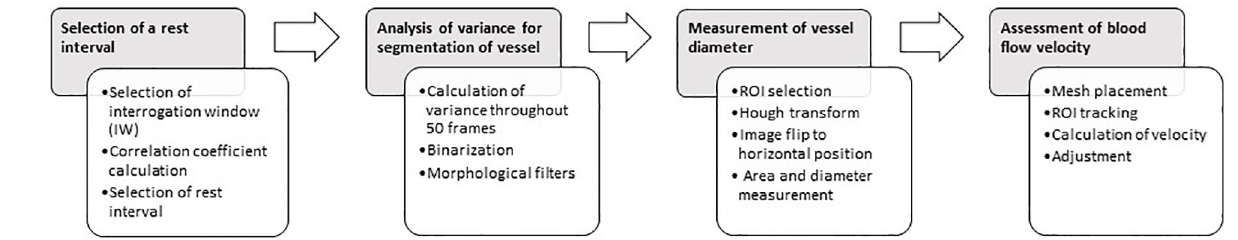
Fig 1. Schematic representation of the